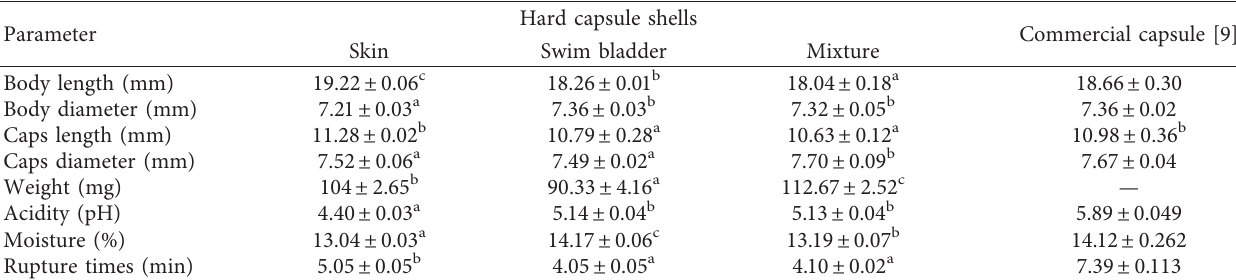
Figure 2: Hard capsule shells from gelatin of Pangasius waste. Table 3: Physical properties of hard capsule shells from Pangasius skin and swim bladder gelatin.